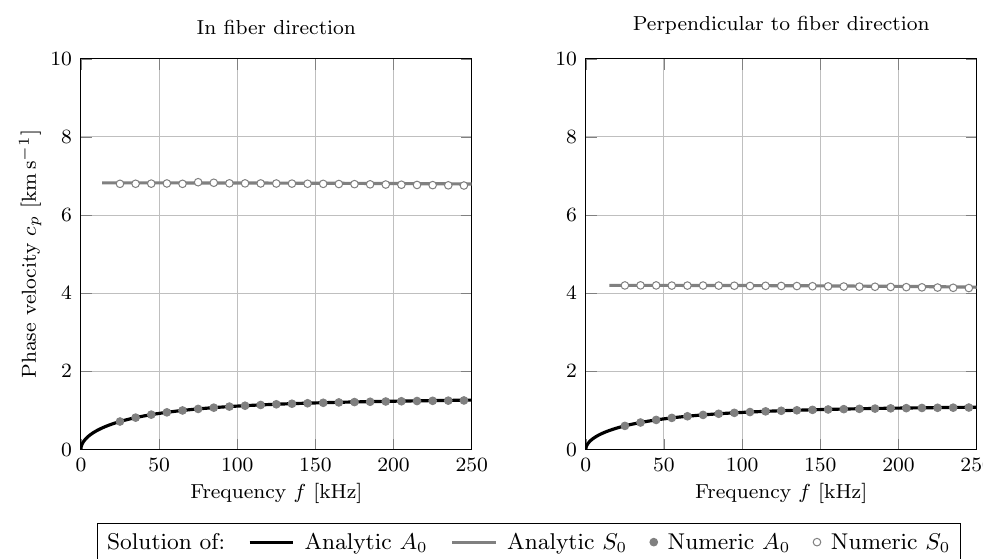
Figure 3. Comparison of numerically and analytically determined dispersion diagrams in fiber direction ( left ) and perpendicular ( right ) to the fiber orientation.